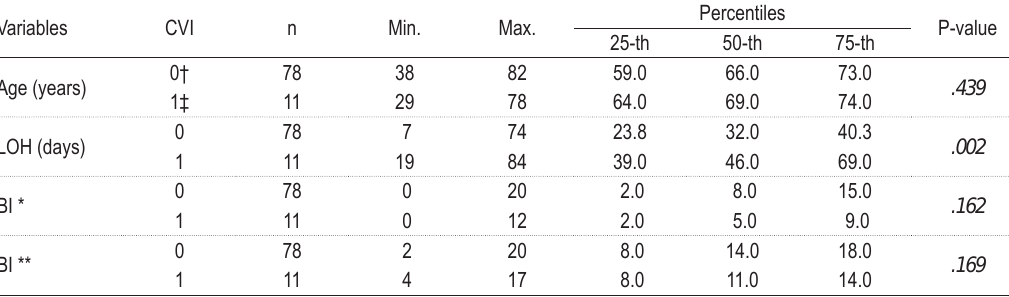
TABLE 1. Descriptive statistics of patients with CVI who were hospitalized at the Clinic for Physical medicine and rehabilitation, Clinical Center University of Sarajevo, 2009, (n=89)